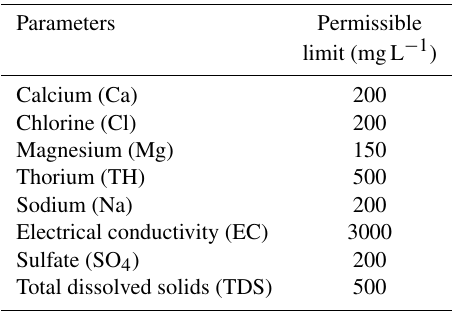
Table 2. Drinking water quality based on content of inorganic com- ponent standards (WHO; Shobha et al.,